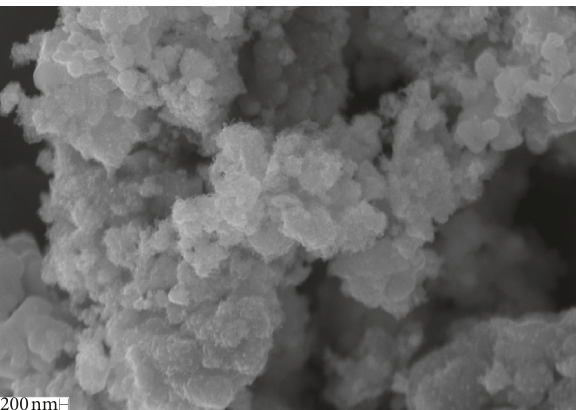
Figure 10: SEM image of sample 40Ni20YZ ( × 25000) after POM